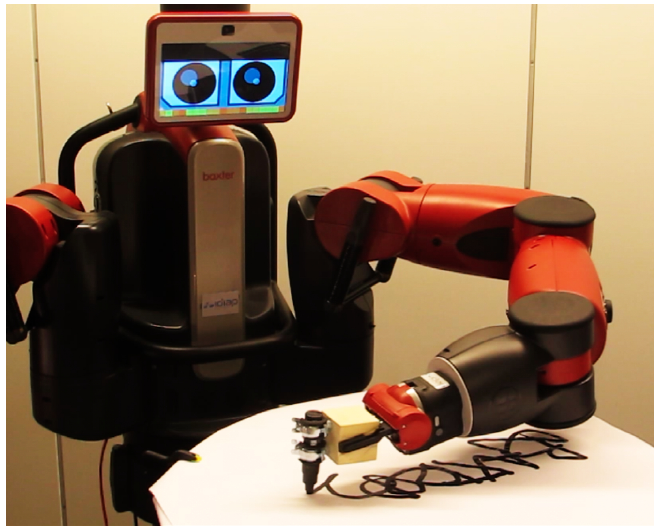
Figure 1. Baxter Signing His Name in Graffiti Style [22].